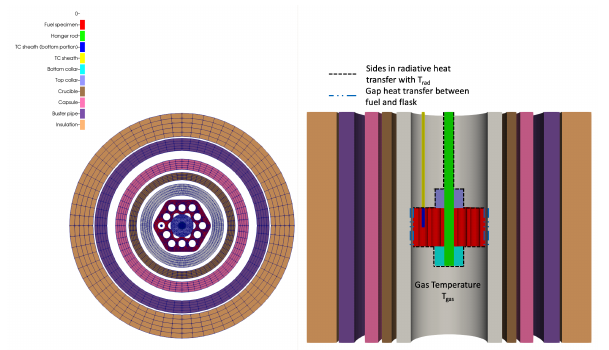
Figure 10. Geometry and mesh of the SIRIUS-CAL specimen and surrounding components for the thermal